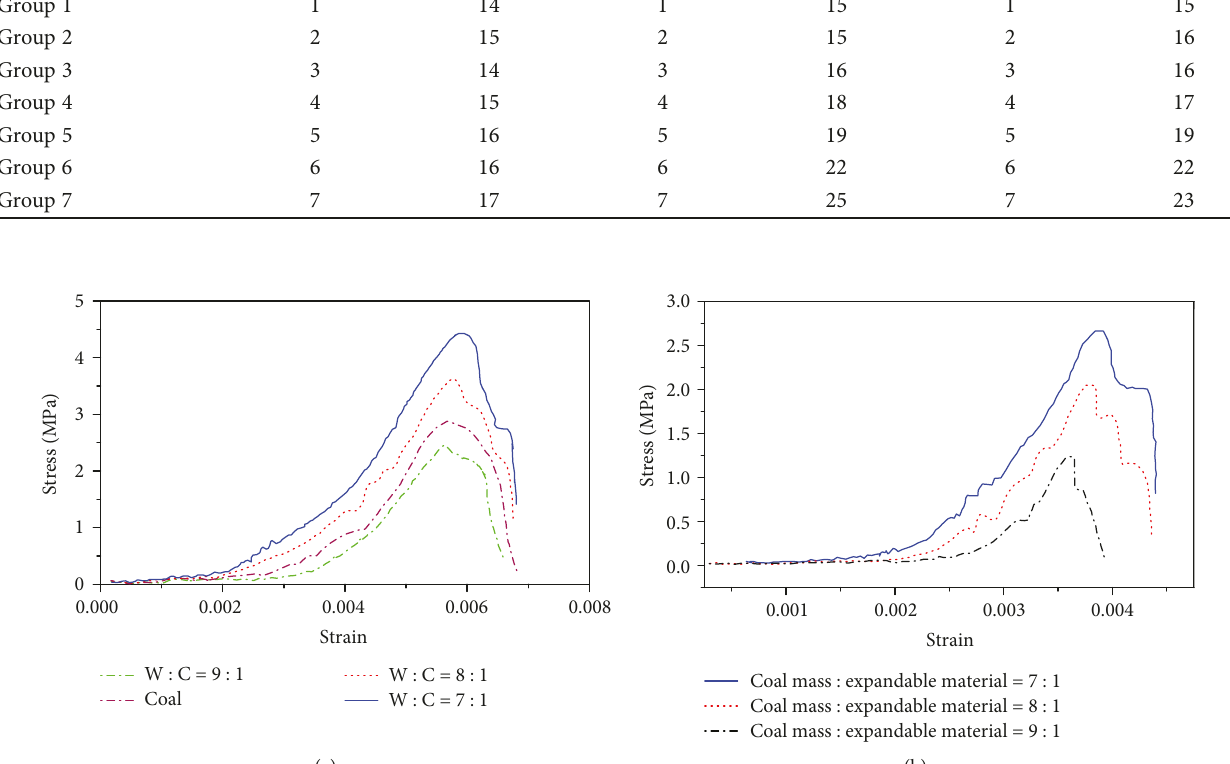
Figure 9: Stress-strain curves: (a) compression curves of expandable materials with high water content of di ff erent water-cement ratios (W :C) and (b) consolidated with coal masses of di ff erent coal-slurry